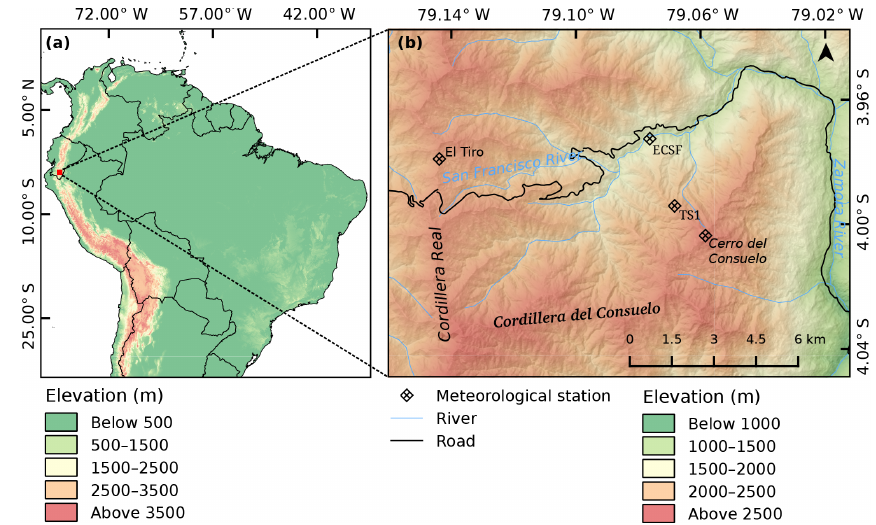
Figure 1. Map of the study area. (a) Location of the study area in the Huancabamba depression of the Andes in South America. (b) Detailed map of the rain and OP sampling sites installed in the study